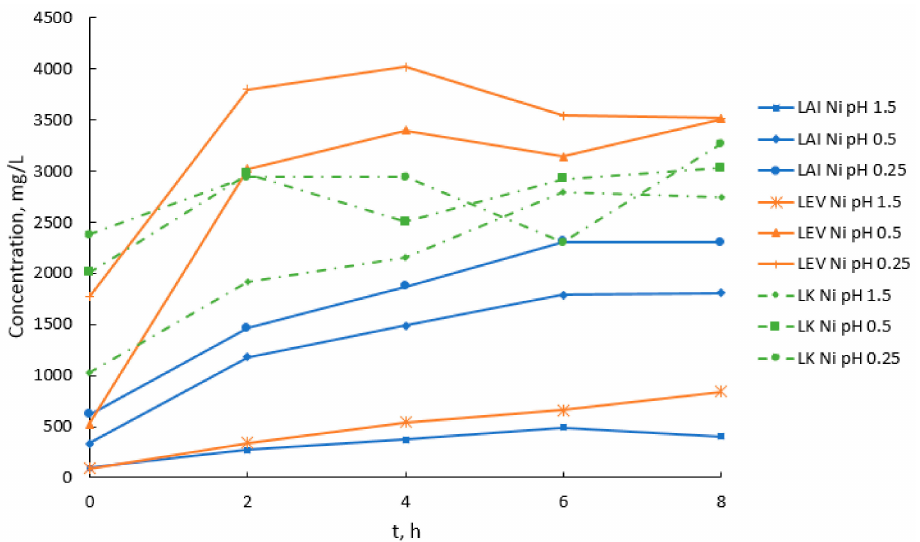
Figure 2. Evolution of Ni concentration vs. time during leaching of LAI, LEV, and LK laterites in pH 0.25, 0.5, and 1.5. Parameters used in the experiments: 90 ◦ C, S / L = 30%, 800 rpm. pH was maintained by H 2 SO 4 addition.